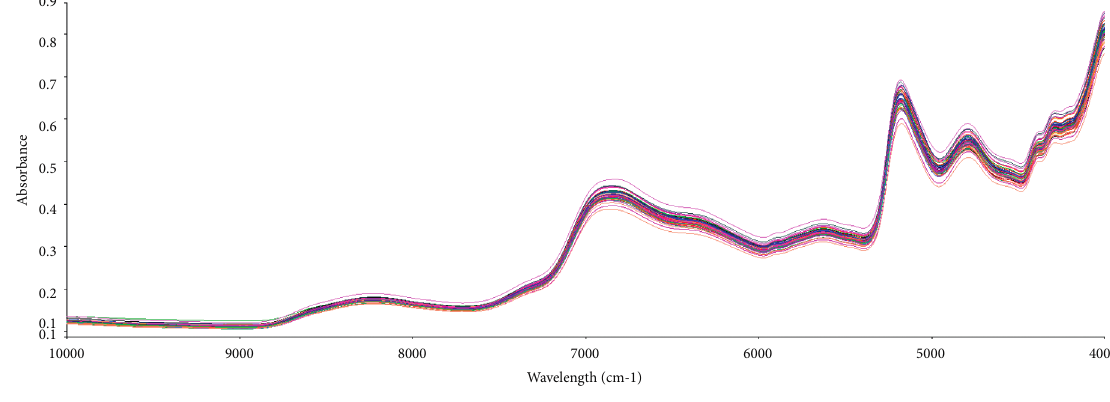
Figure 2: NIR spectrum of Poria